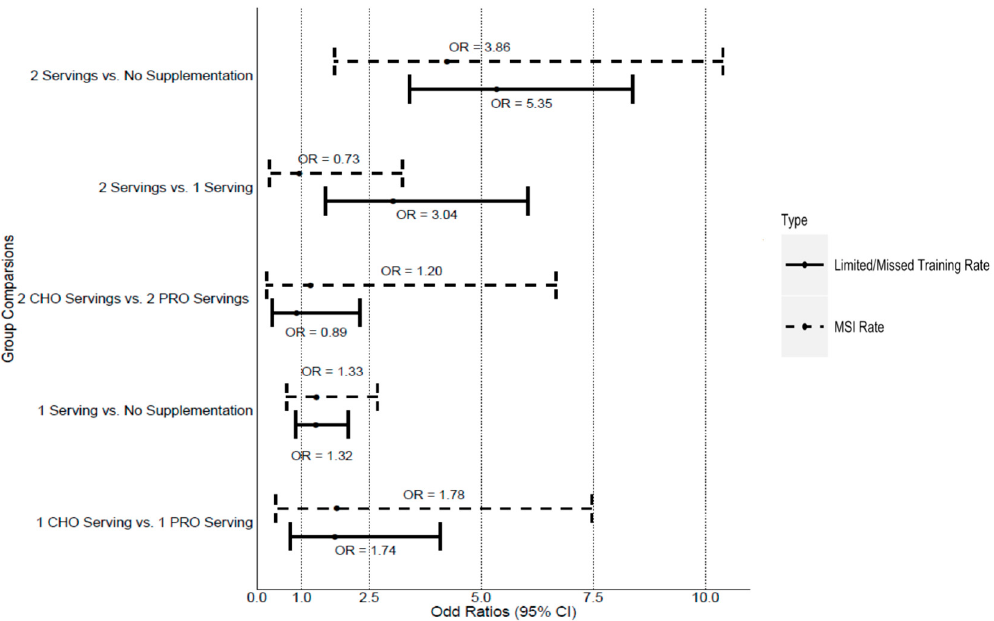
Figure 1. Odds ratio of MSI rates and limited/missed duty rate between groups. Abbreviations: Protein (PRO), Carbohydrate (CHO), Odds Ratio (OR).